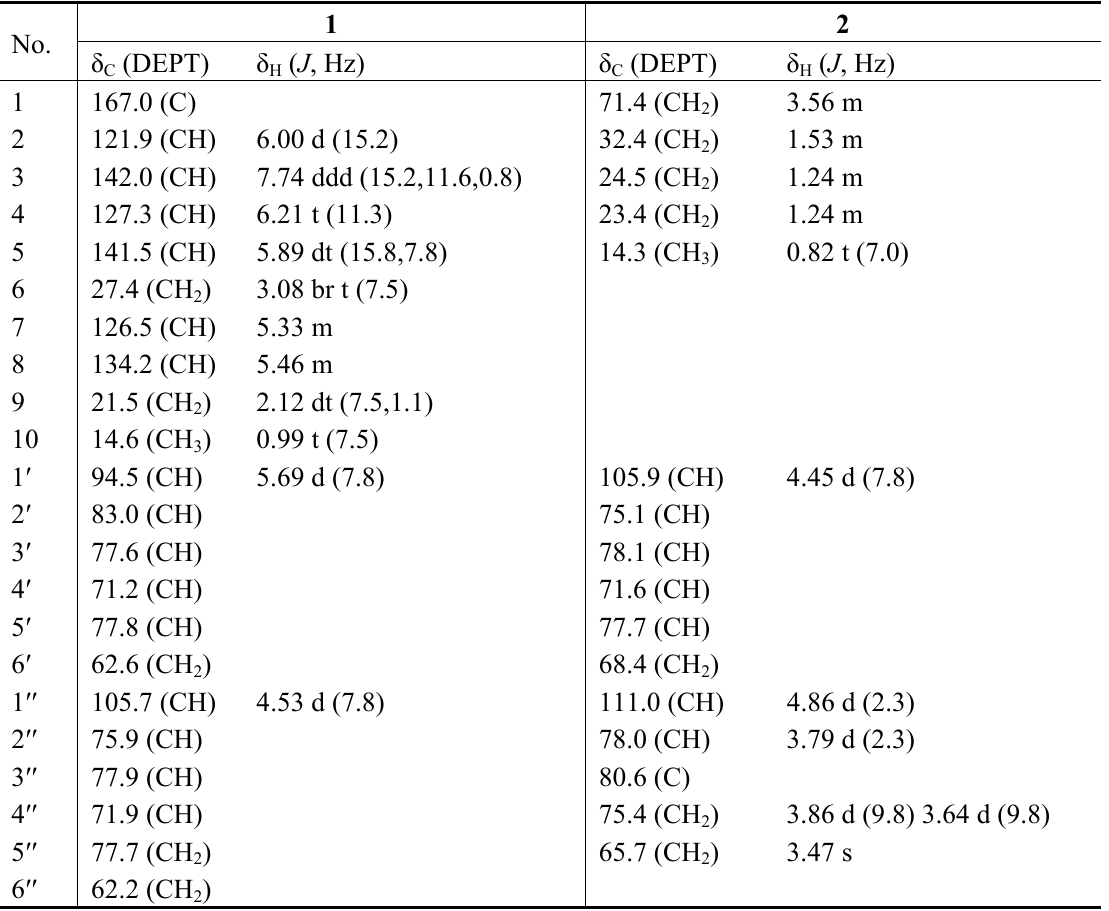
Table 1. NMR data of 1 and 2 in CD 100 MHz, respectively).